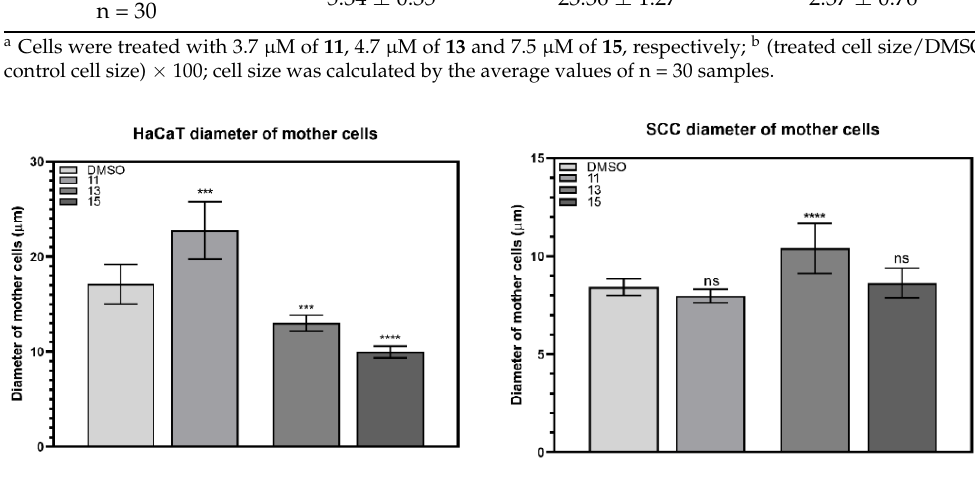
Figure 3. Effect of DMSO and compounds 11 , 13 and 15 on the mother cell sizes of HaCaT and SCC cells. (Asterisks and “ns” refer to the levels of significance of the data based on the statistical significance test; ns: not significant ( p > 0.05), *** p < 0.001, **** p < 0.001; p = probability level).